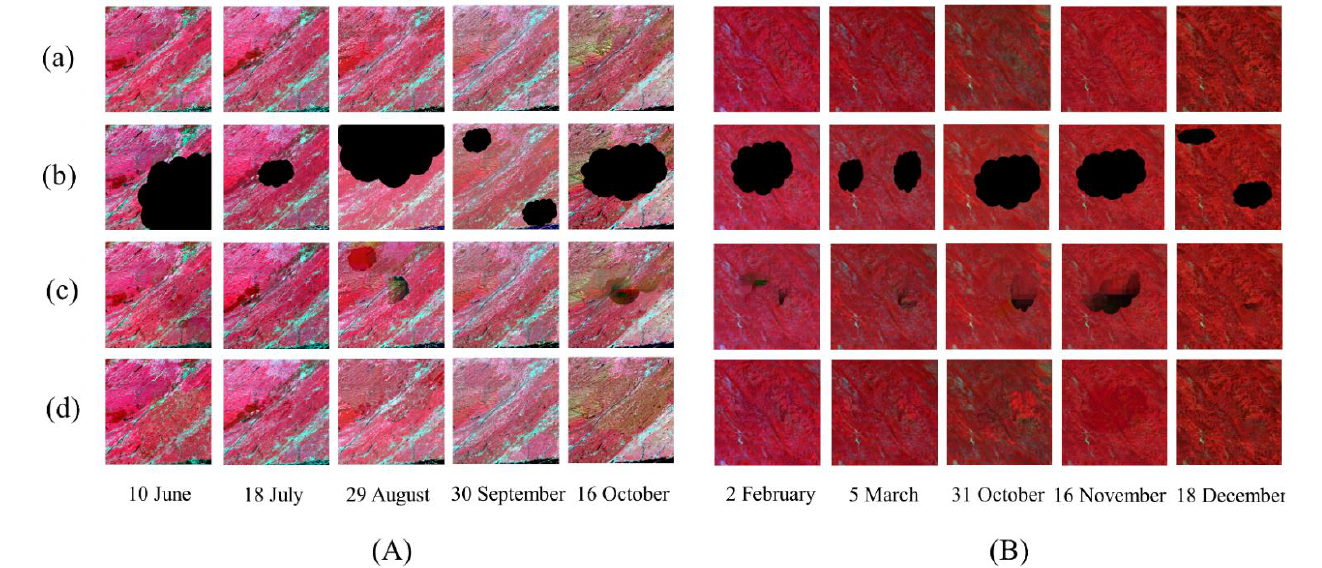
Figure 9. The time series of images are shown for ( a ) the original data, ( b ) the simulated masks, ( c ) the recovery results using Zhang’s method, and ( d ) the recovery results using CSTG. ( A , B ) are two different scenes to simulate large missing areas and overlapped missing areas respectively. The original images were acquired in 2017 and 2020,